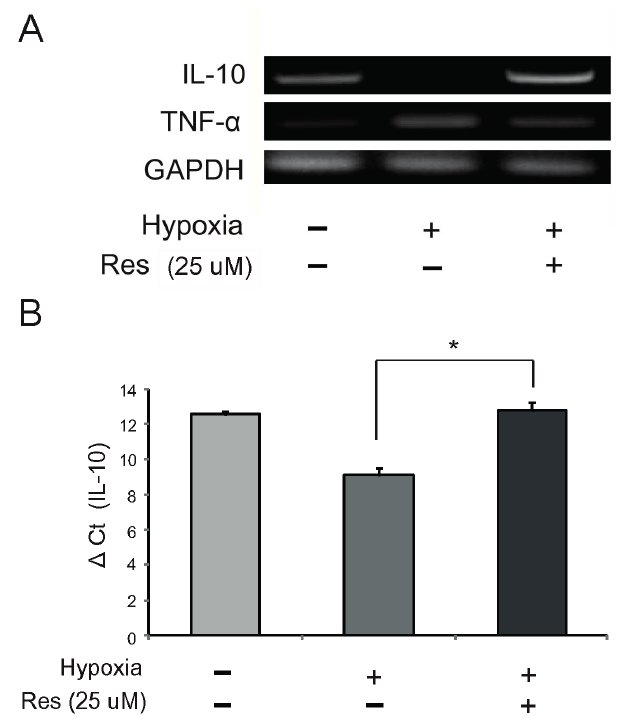
Figure 3. The mRNA levels of IL (interleukin)-10 and TNF (tumor necrosis factor)- α in hypoxia-injured BV2 microglia. The mRNA levels of IL-10 and TNF- α were measured using reverse transcription PCR ( A ) and quantitative real time PCR ( B ). ( A ) The mRNA level of IL-10 was decreased in the hypoxia injury group compared to the normal control group. Resveratrol (25 μ M) increased the mRNA level of IL-10 in hypoxia-injured microglia. The mRNA level of TNF- α was increased in the hypoxia injury group compared to the normal control group. Resveratrol (25 μ M) reduced mRNA level of TNF- α in hypoxia-injured microglia; ( B ) Δ C value also shows that resveratrol (25 μ M) increased t mRNA levels of IL-10 under hypoxia injury. GAPDH was used as a control (mean ± S.E.M., n = 3). * p < 0.05 (compared to the hypoxia